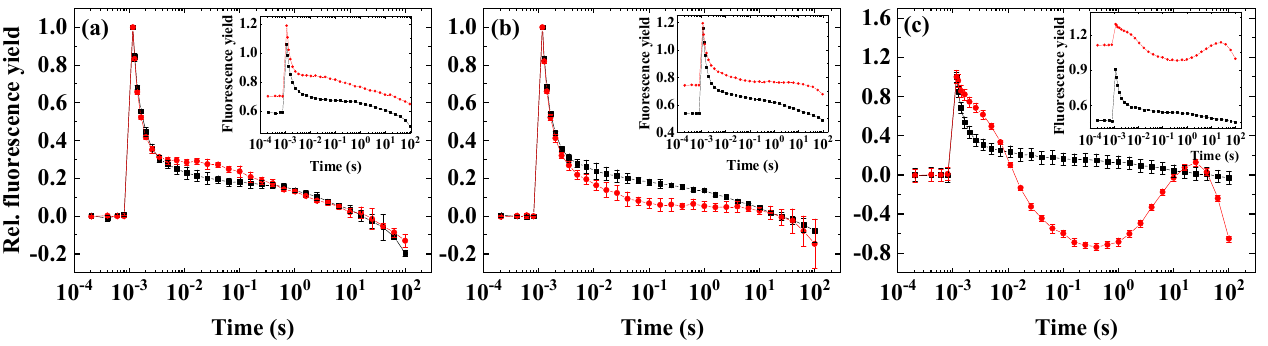
Figure 5. Flash-induced fluorescence relaxation in red cells of H. pluvialis . ( a ) Control cells without inhibitor under aerobic (black) and microaerobic (red) conditions. ( b ) HA-treated cells under aero- bic conditions (red). ( c ) HA-treated cells under microaerobic conditions (red). The black traces in panels b and c show the aerobic untreated control as in panel a. Curves shown in panels a, b and c were double normalized (F 0 to 0 and F m(ST) , which represents maximal fluorescence after the flash to 1) to achieve the same initial amplitudes. Insets show the original traces, averaged over the three biological replicates, of the respective conditions without normalization. Error bars represent the standard deviation of the mean of three biological replicates.